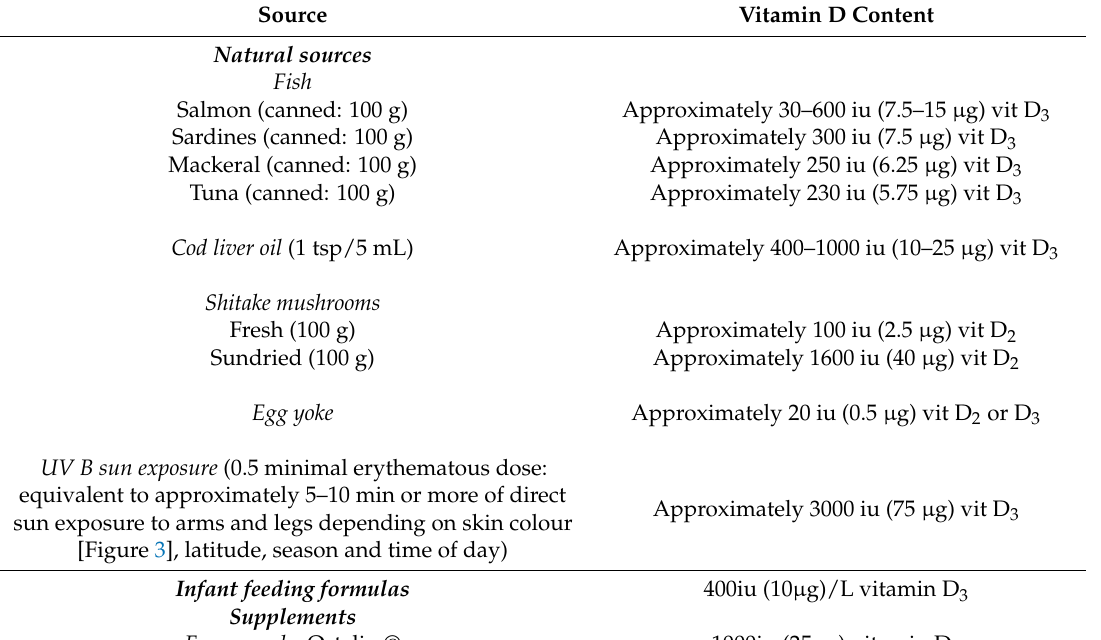
Table 1. Dietary, supplemental and pharmaceutical sources of vitamin D 2 and D 3 adapted from Holick [23]. Copyright permission was obtained from the